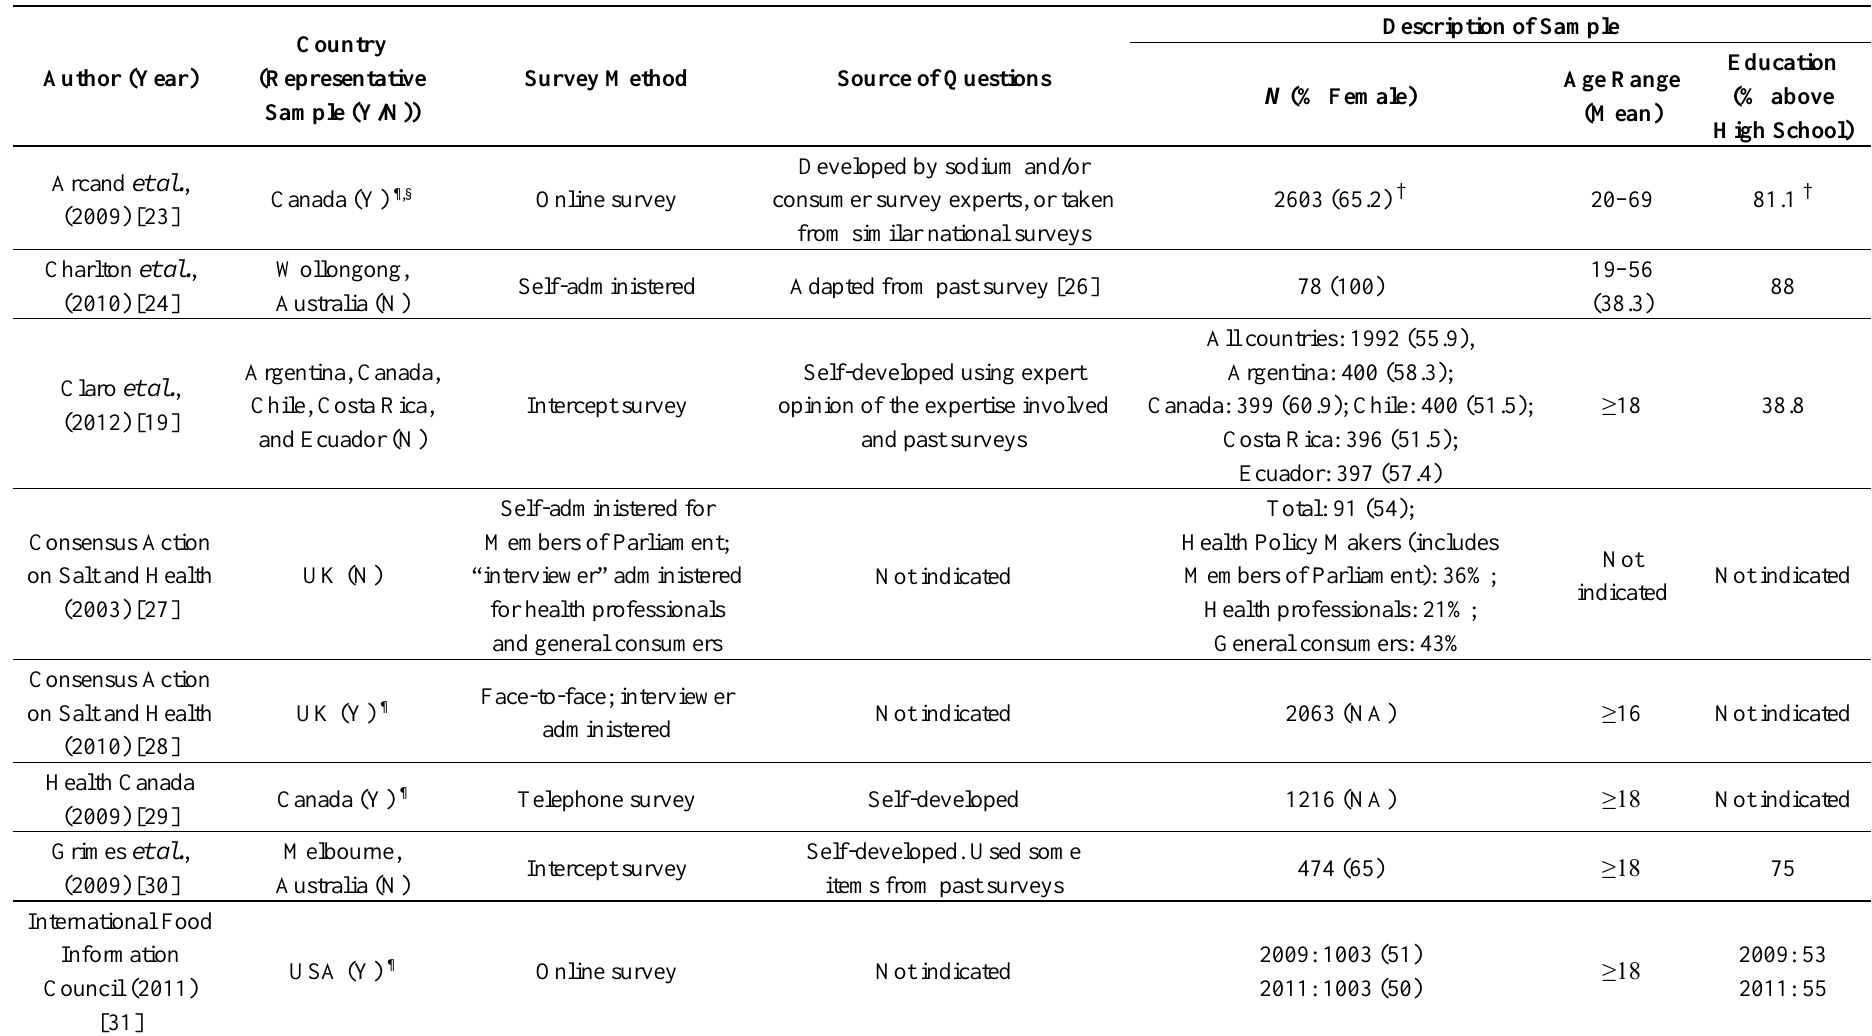
Table 1. Description of studies included in the